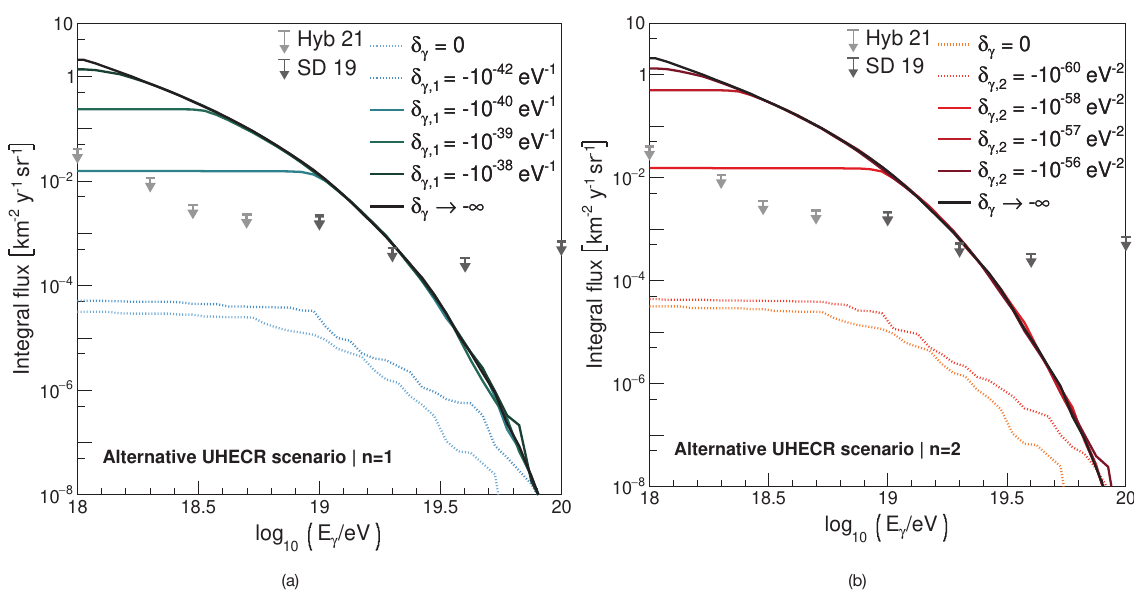
Figure 2. Simulated integral flux of GZK photons as a function of the energy for an alternative scenario with subdominant proton component. Continuous lines show the rejected LIV scenarios. The arrows show the flux determined by analysis of the Pierre Auger Observatory data. LIV at first order (a) and LIV at second order (b). Figures from [9].